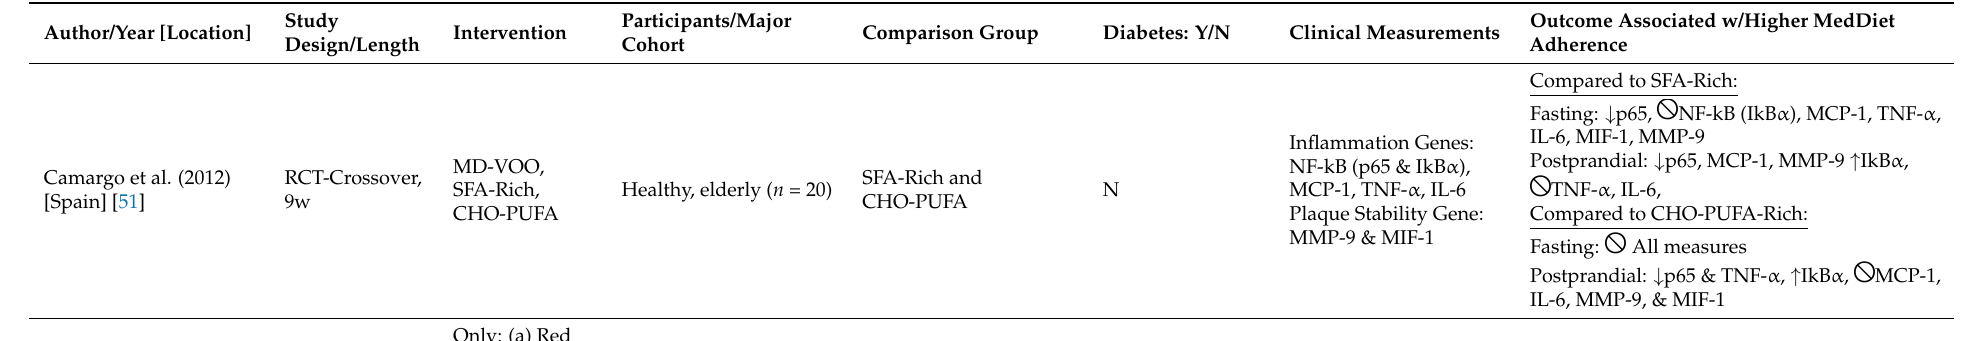
Table 2. Clinical Studies.